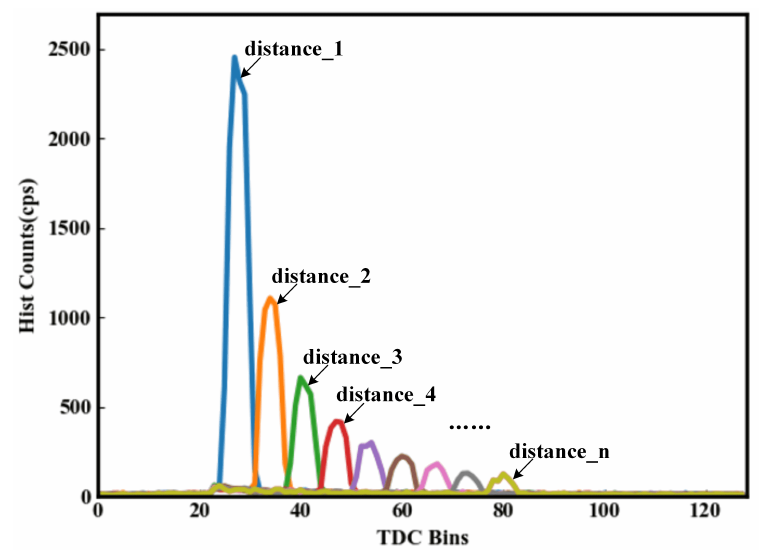
Figure 4. The histogram data distribution at different